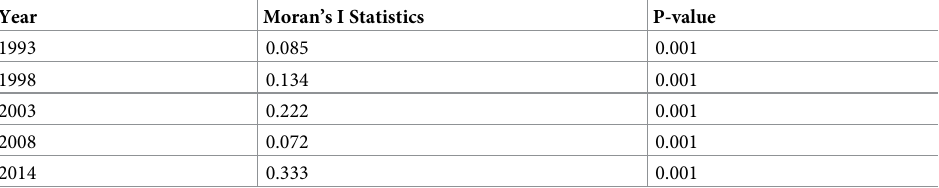
Table 2. Testing for global spatial autocorrelation using Moran’s I statistics for each survey